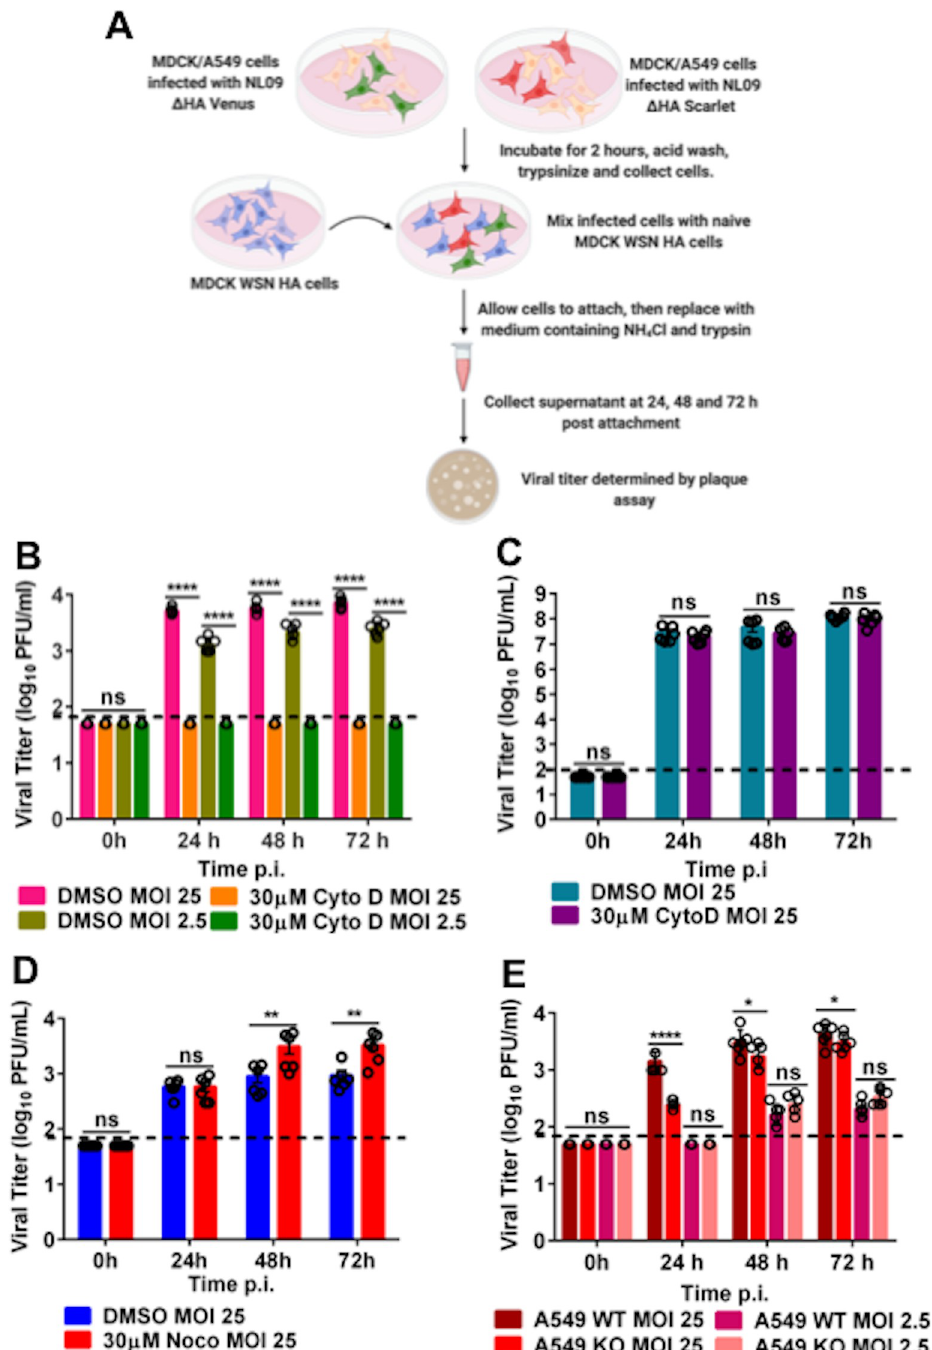
Fig 5. Virion-independent genome transfer leads to productive infection by an actin-dependent mechanism. [A] Experimental workflow for MDCK, A549 WT or A549 Rab11a KO infection and co-culture with MDCK WSN HA cells [generated via BioRender.com]. Plotted is the infectious virus yield from co-culture of MDCK WSN HA cells with MDCK cellsinfected with NL09 Δ HA Venus WT and NL09 Δ HAScarlet VAR viruseseither treated with Cytochalasin D [B] or Nocodazole [D]. [C] Infectious virus yield from MDCK cells infected with NL09 viruses and treated with Cytochalasin D. [E] Infectious virus yield from co-culture of MDCK WSN HA cells with A549 WT or Rab11a KO cells infected with either NL09 Δ HA Venus WT or NL09 Δ HAScarlet VAR viruses. Significance of differences between the control and Cytochalasin D or Nocodazole treated cells or between WT and KO cells was tested using 2-way ANOVA with Bonferroni’s correction for multiple comparisons [ � P-value < 0.1; �� P-value < 0.01; ��� P-value < 0.001; ���� P-